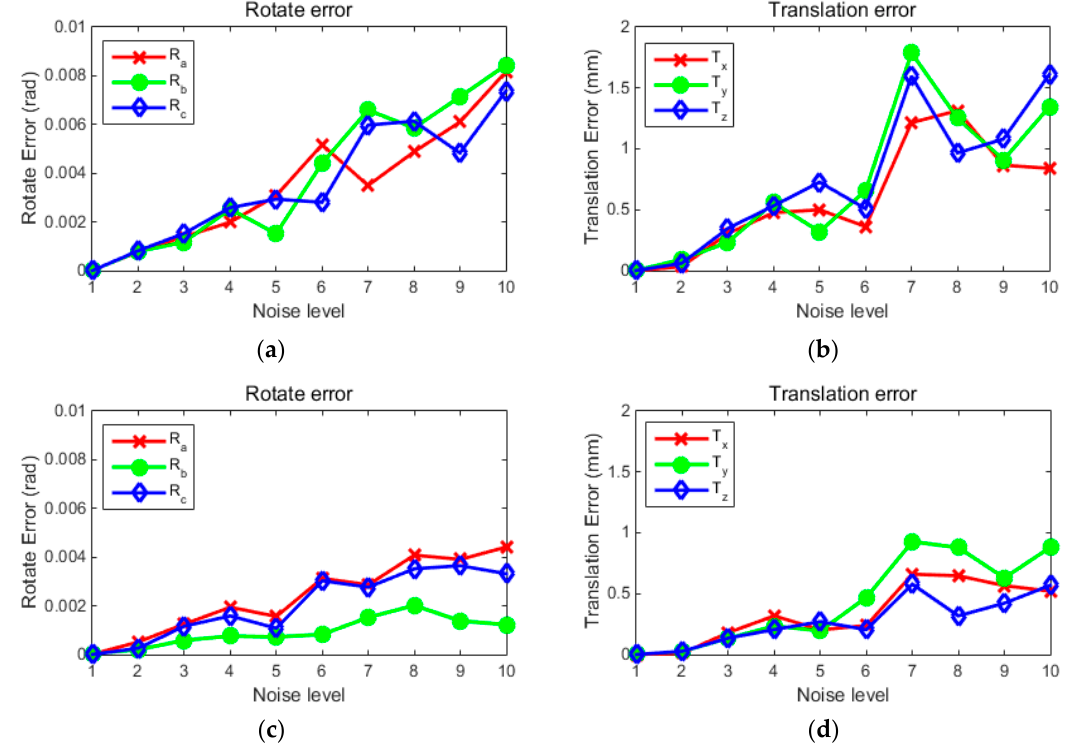
Figure 3. The RMS error curve of the calibration result affected by noise. The graph ( a ) shows the three rotation angle error curves obtained with the linear solution method with ten noise levels. The graph ( b ) shows the translation error curve obtained with the linear solution method with ten noise levels. The graph ( c ) is the rotation angle error curve after optimization of the re-projection error. The graph ( d ) is the translation error curve after optimization of the re-projection error.